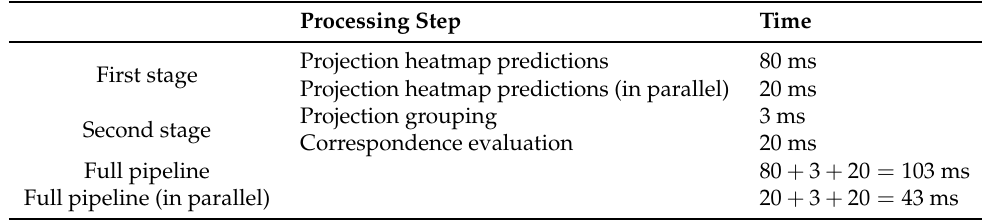
Table 4. The runtime statistics of different subparts in the complete